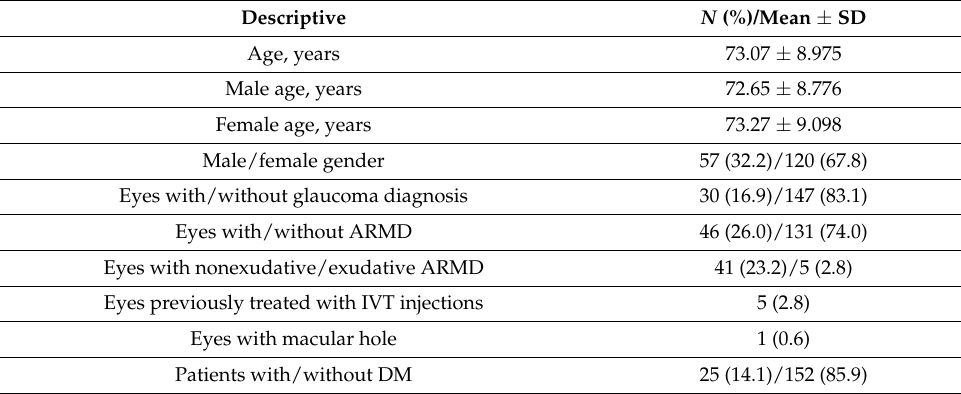
Table 1. Demographic data and comorbidities 1